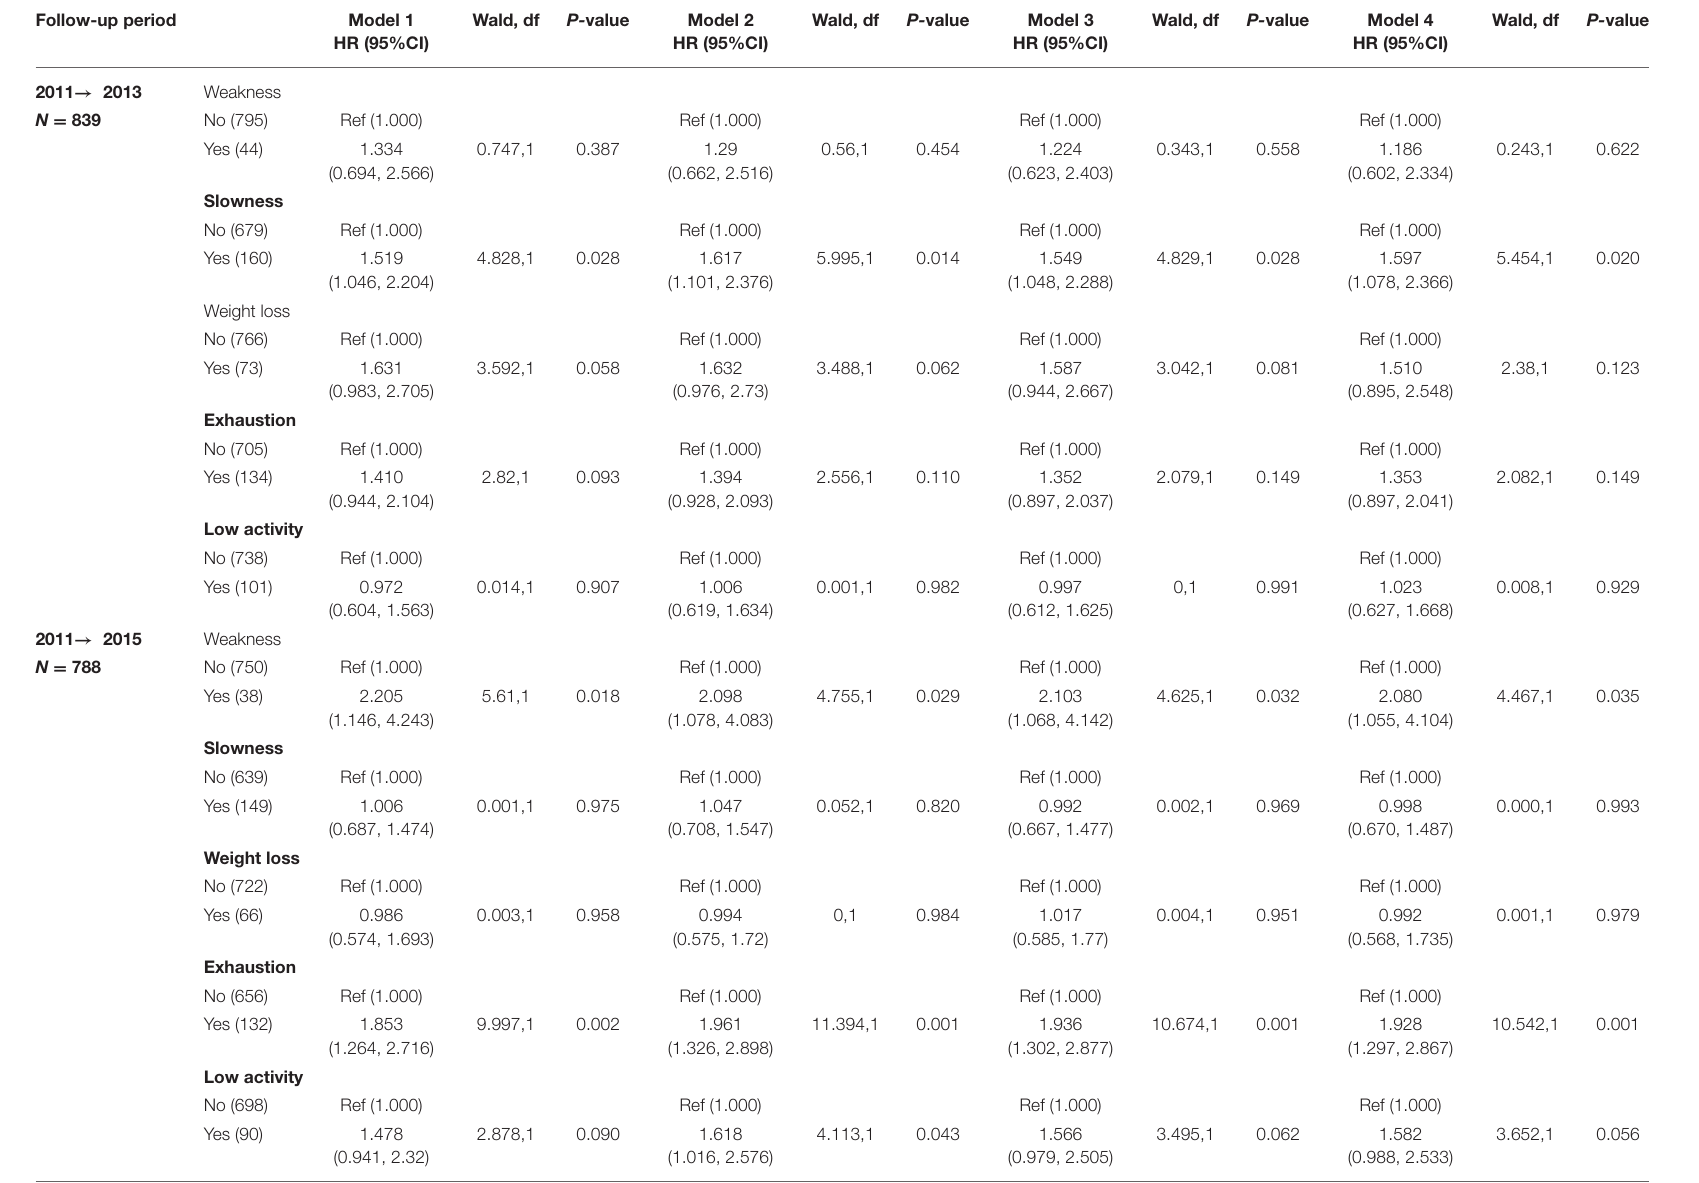
TABLE 6 | Association between components of frailty and incident depressive symptoms not depressed at baseline. Follow-up